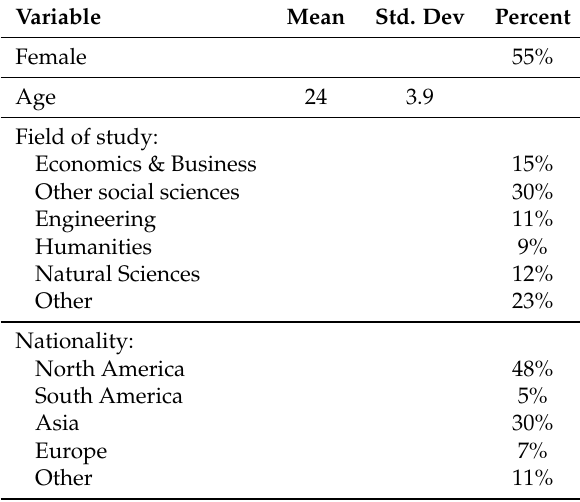
Table 1. Summary